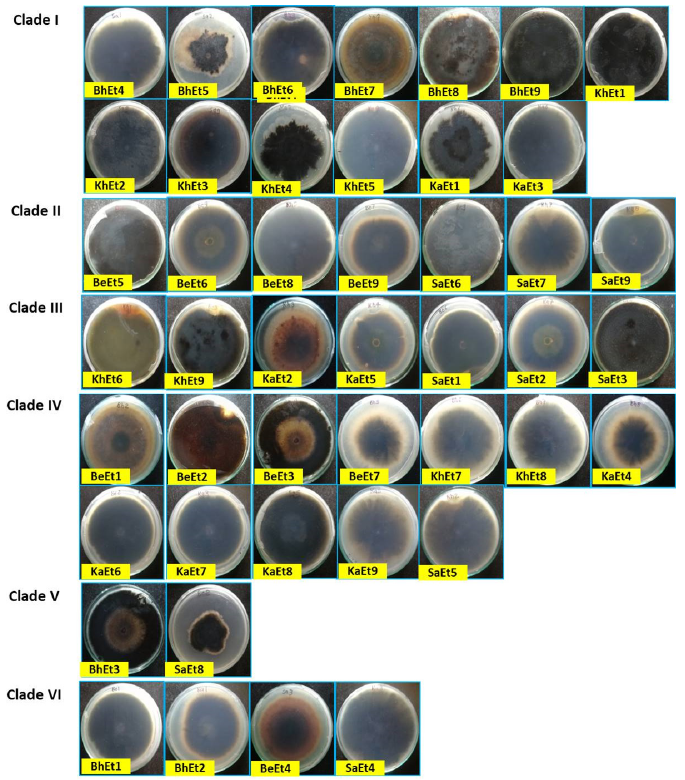
Figure 2. Cultural and morphological variability of different isolates of E. turcicum on PDA (inverted view) 10 days after inoculation.